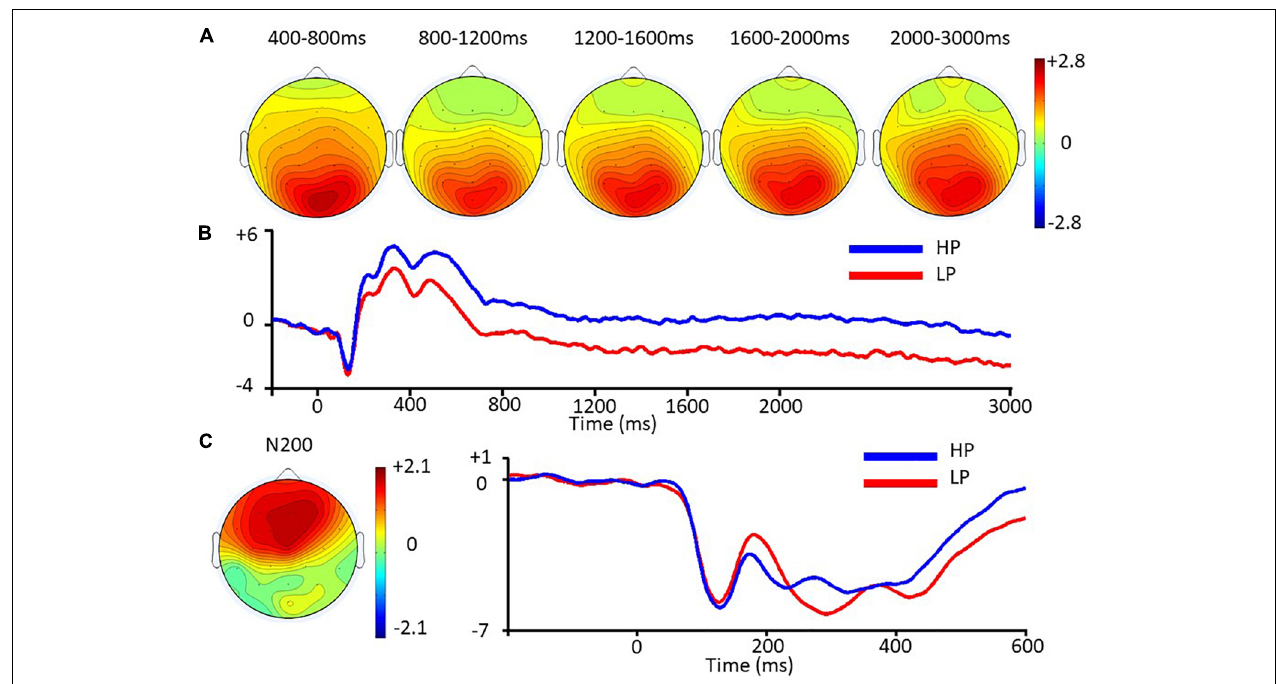
FIGURE 3 | ERPs as a function of behavioral preferences. (A) Left: Two-dimensional scalp map plotting contrasts of late positivities between HP and LP. (B) ERP waveforms from Pz time-locked to the onset of pictures displaying consumer goods (second phase) separated by behavioral preferences. Amplitude in microvolts is on the y axis and time in milliseconds on the x axis. (C) Left: Two-dimensional scalp maps plotting contrasts of N200 peak to peak amplitudes between HP and LP. Right: ERP waveforms from Fz time-locked to the onset of pictures displaying consumer goods (second phase) separated by behavioral preferences. Amplitude in microvolts is on the y axis and time in milliseconds on the x